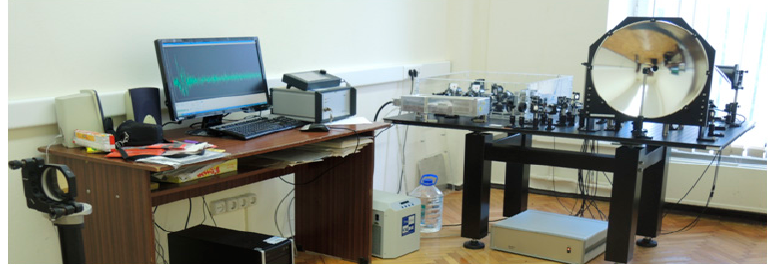
Figure 1. Experimental setup for THz signal measuring at long distance [38].